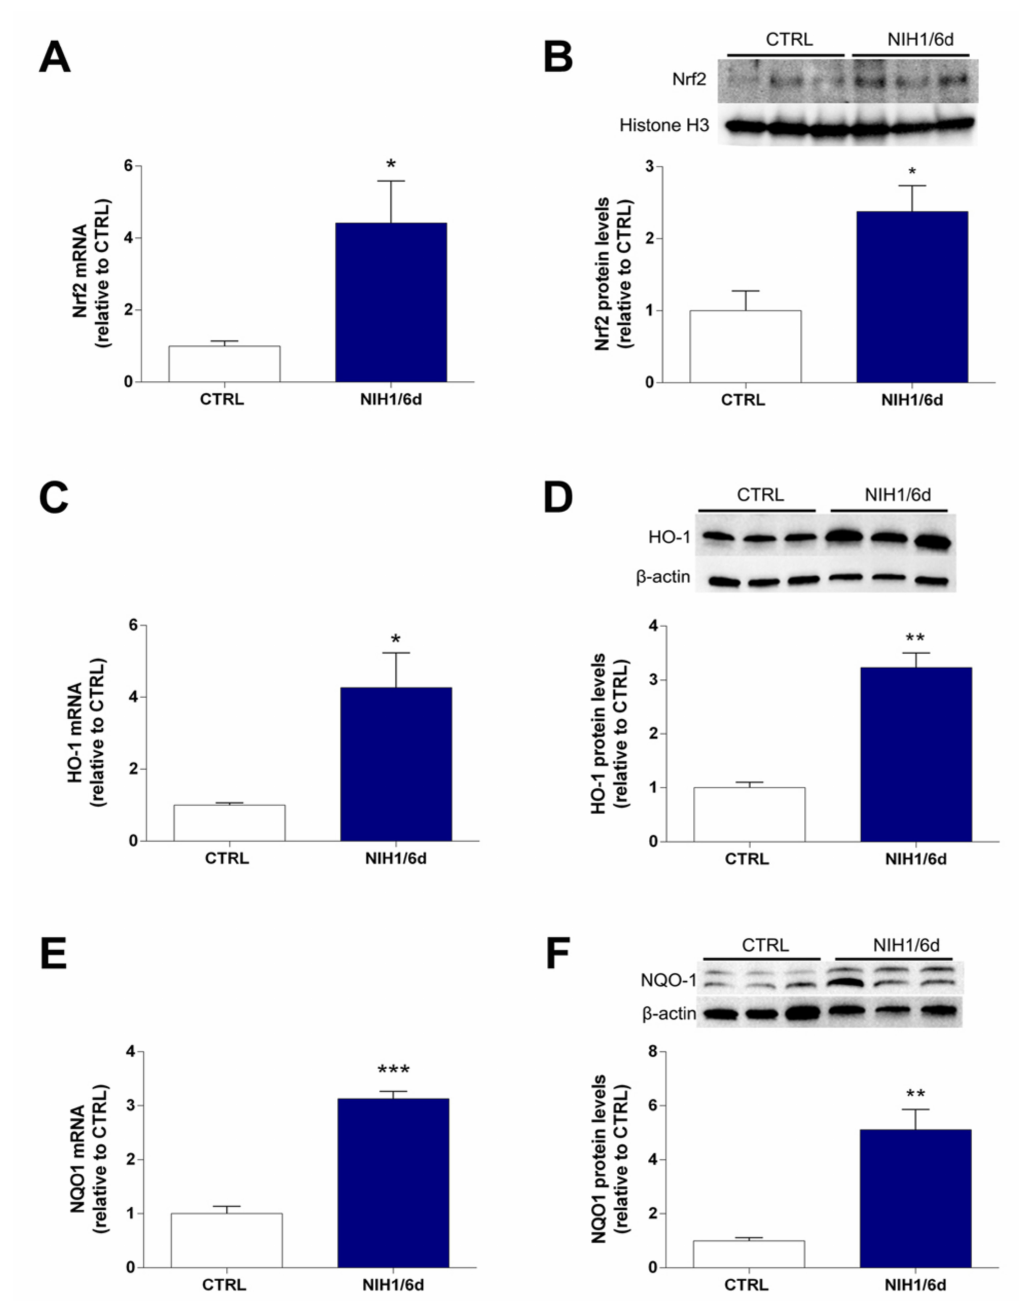
Figure 3. Long-term effects of NIH1 on Nrf2 activation and related antioxidant enzymes. The mRNA levels of Nrf2 ( A ), HO-1 ( C ), and NQO-1 ( E ) were evaluated with qPCR in CTRL explants and in retinal explants treated with 50 µ M NIH1 for six days. ( B ) Western blot of nuclear protein fraction showing representative immunoreactive bands and quantitative densitometric analysis of the Nrf2 protein levels in CTRL and in retinal explants treated with 50 µ M NIH1 for six days. ( D , F ) Western blot analysis of total protein fraction showing representative immunoreactive bands and quantitative densitometric analysis of the HO-1and NQO1 (respectively) protein levels in CTRL and in retinal explants treated with 50 µ M NIH for six days. Unpaired t-test, n = 3; * p < 0.05, ** p < 0.01, *** p < 0.001 vs.